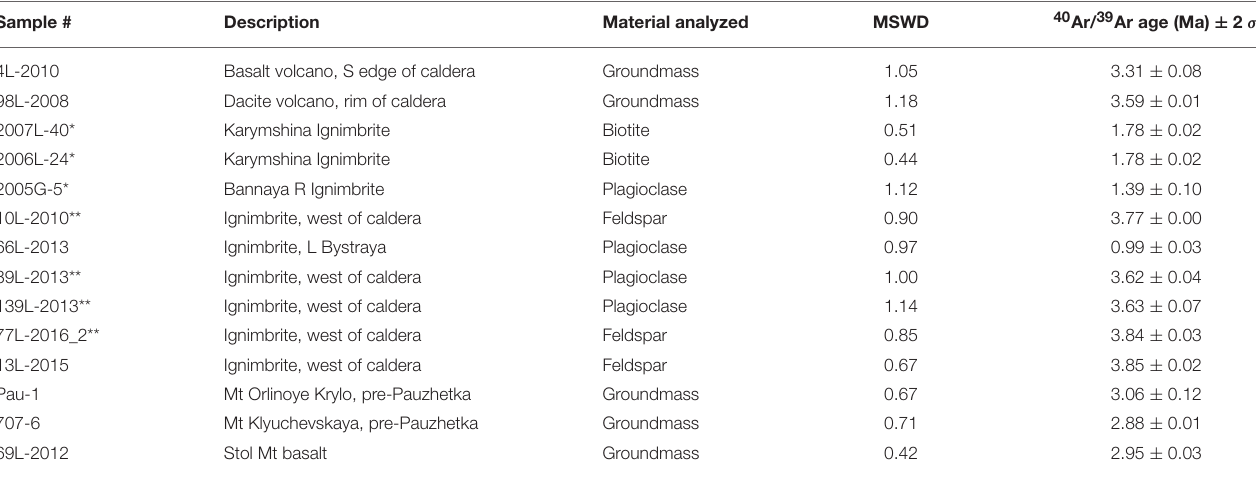
TABLE 2 | Summary of 40 Ar/ 39 Ar ages of this study